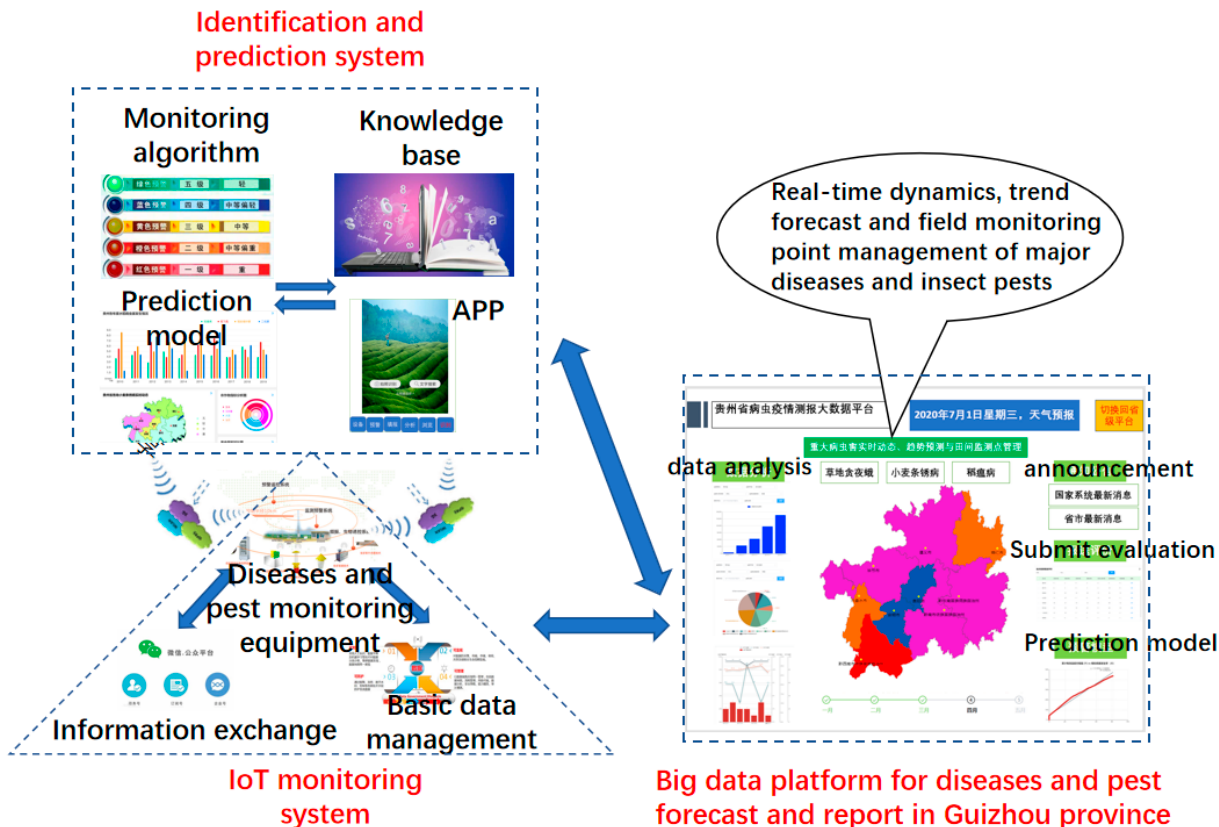
Figure 3. The architecture of the epidemic monitoring and warning system for hot peppers in Gui- zhou.